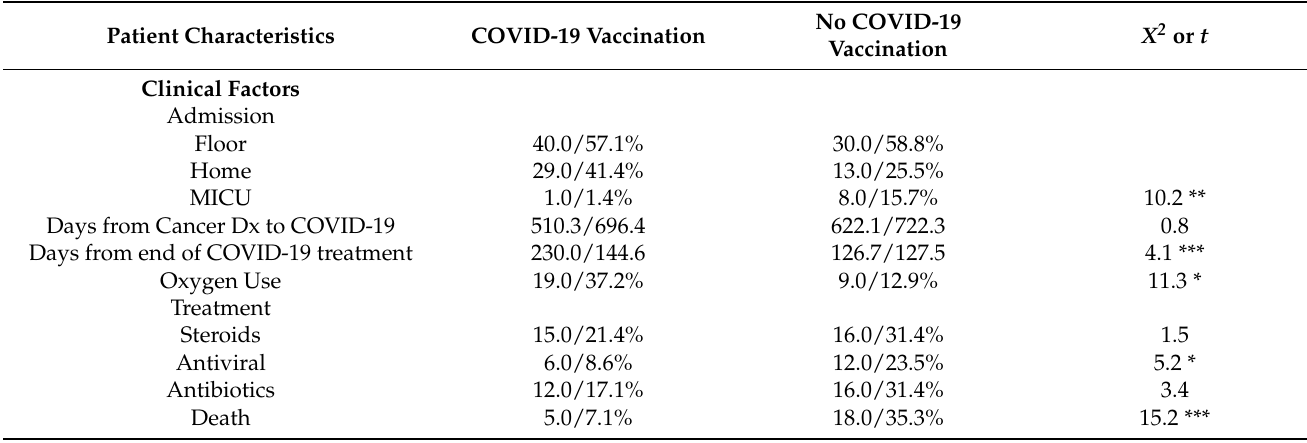
Table 3. Association between clinical factors and COVID-19 vaccination status, COVID-19 infection ( n = 121).